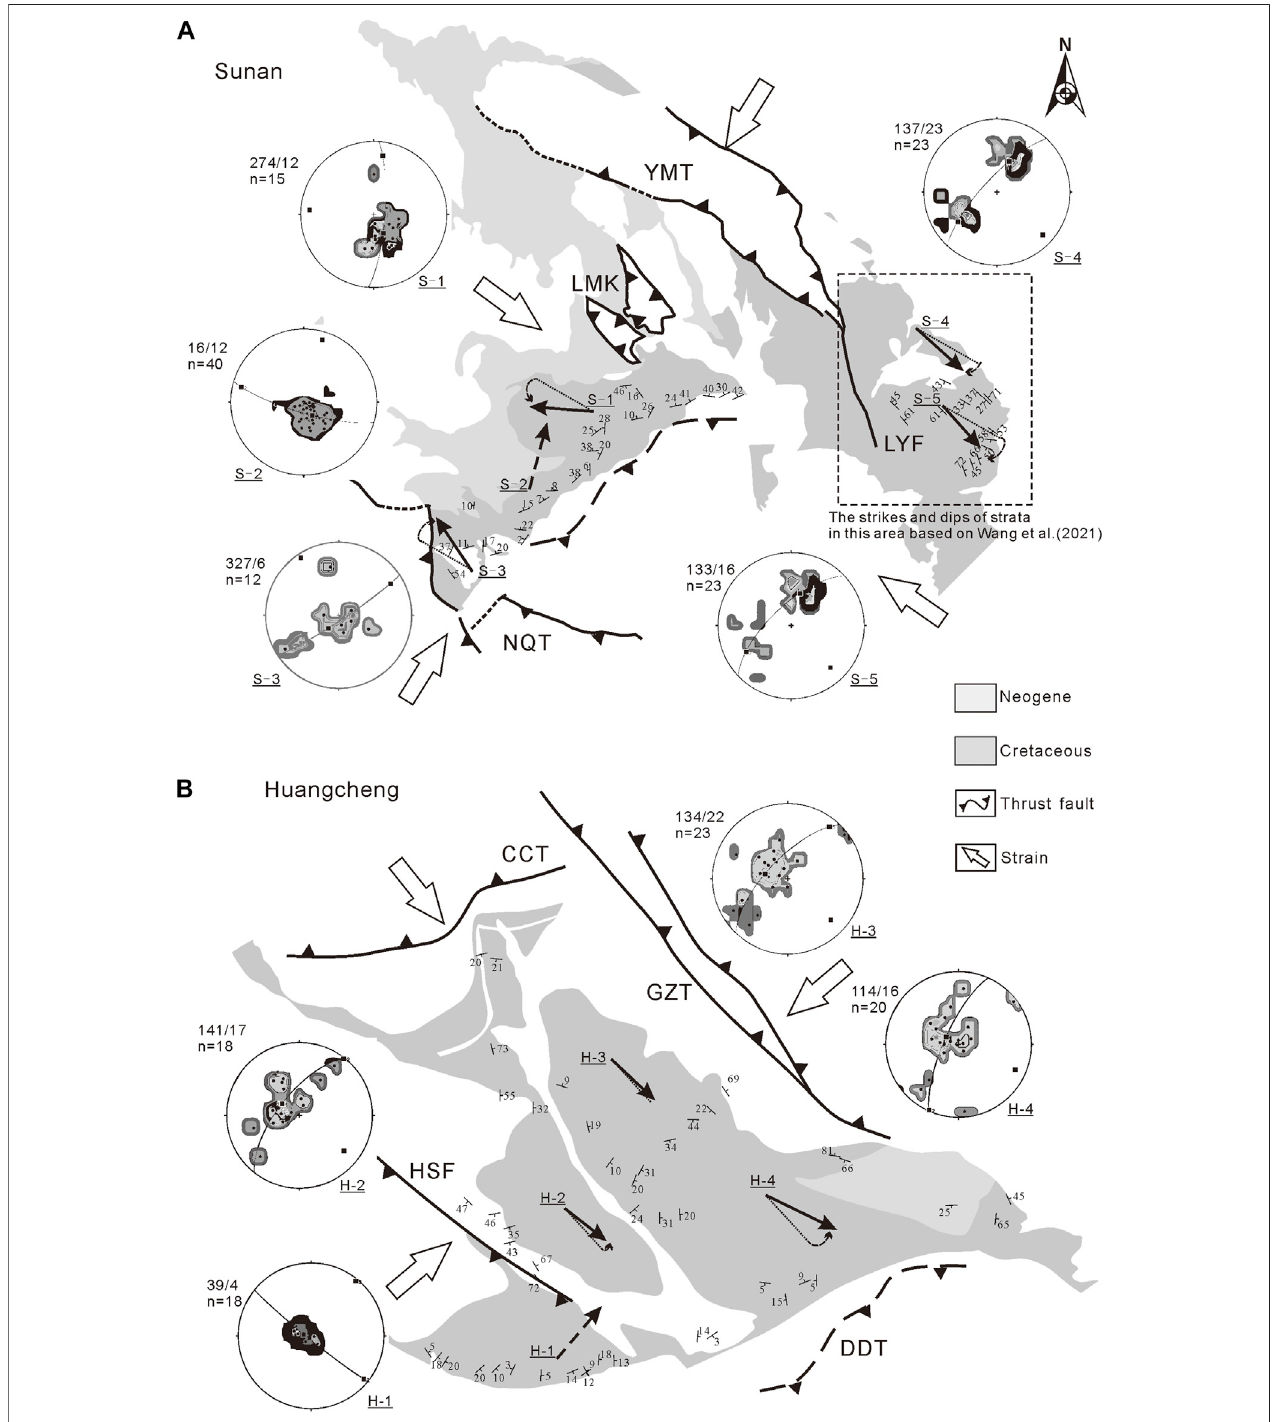
FIGURE 11 | Stereographic projection of the study area. Based on data from the Bureau of Mineral Resources of Gansu Province (BMRGP, Regional Geological Survey)(1982),Wang et al.(2021), and fi eldworkconducted forthisstudy. Thedots inthestereographic projection represent stratadatawhile circles represent the best fi t transection of the fold; thus, the pole of the circle is the simulated fold hinge, which shows the plunge. Arrows indicate the simulated fold hinge. (A) Stereographic projection of the Sunan basin. (B) Stereographic projection of the Huangcheng basin.